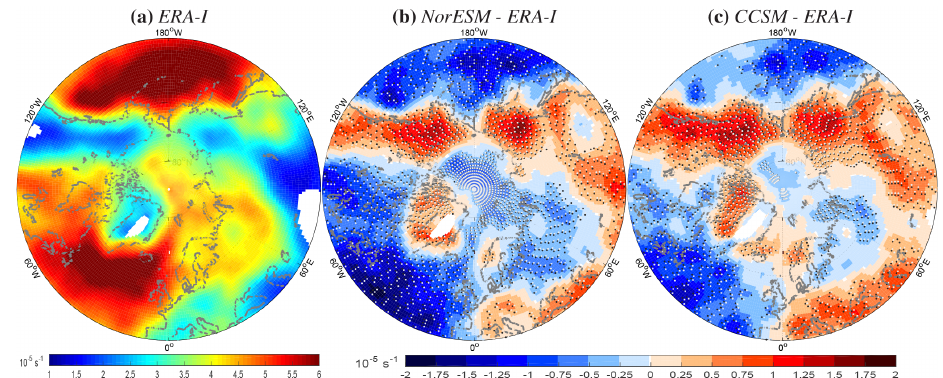
Figure 8. Mean intensity average for SOND 1979–2005 in (a) ERA-I and bias of (b) NorESM and (c) CCSM compared to ERA-I. Regions with track density below 0.5 no. density (month) − 1 (10 6 km 2 ) − 1 are shaded white. Alternating black and white dots in panel (b) and (c) mark regions where p < 0 . 05 based on 2000 samples.